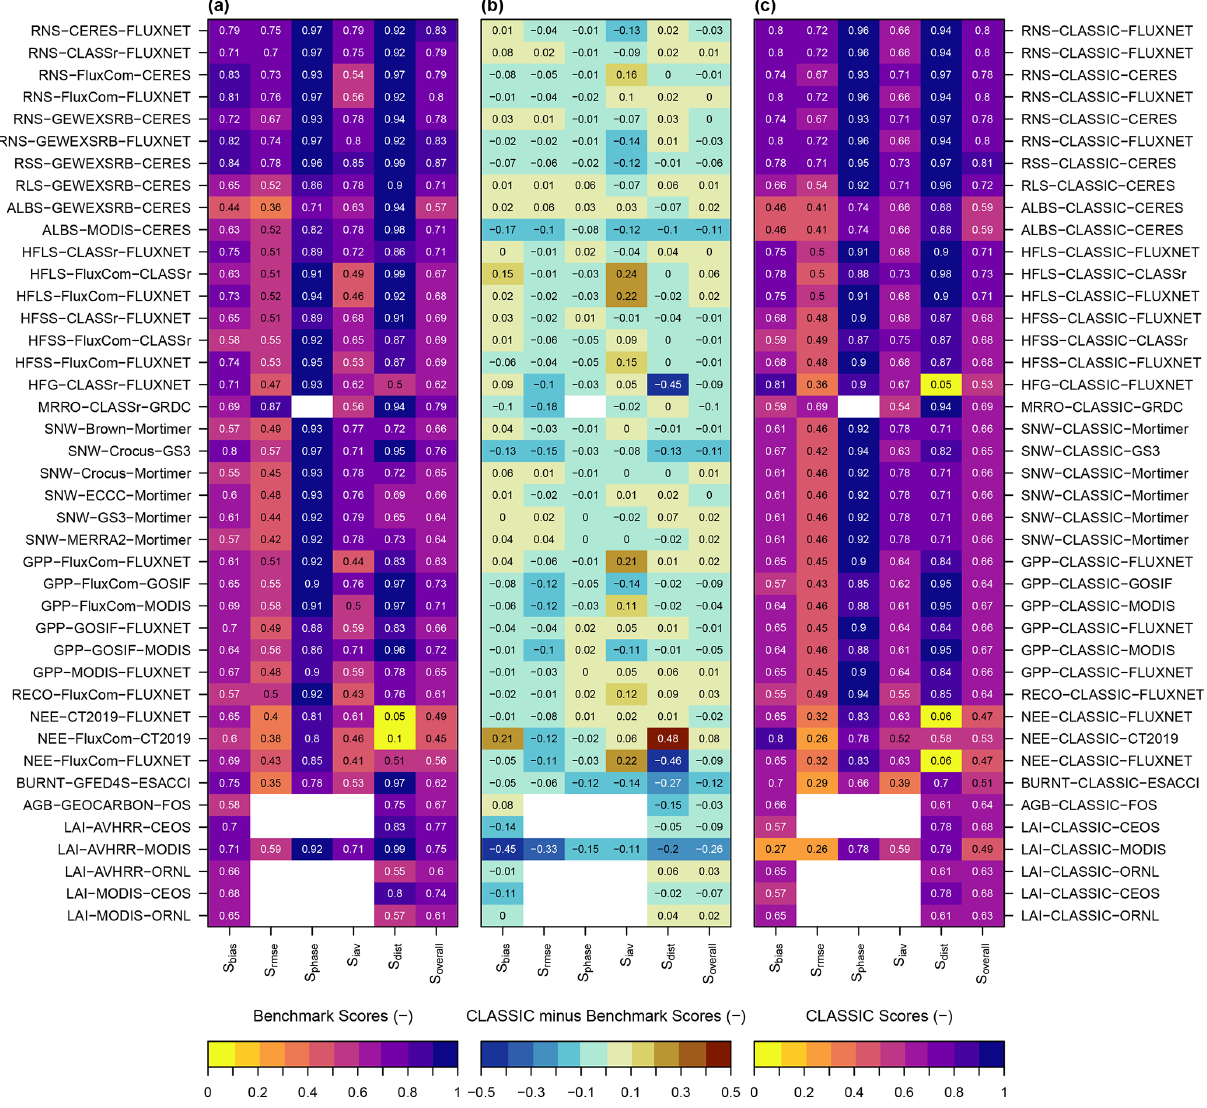
Figure 13. (a) Benchmark scores computed from reference data only, (c) mean model ensemble skill scores, and (b) corresponding score